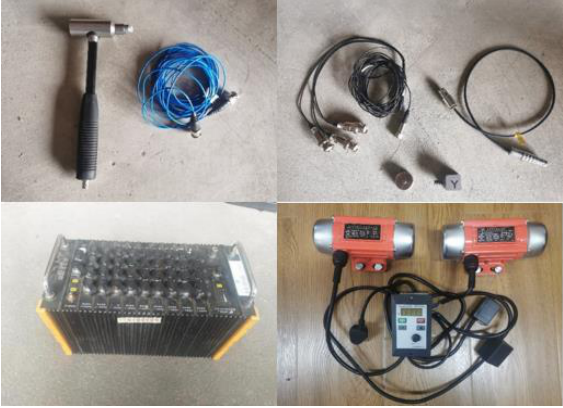
Figure 5. Equipment of vibration signal acquisition.